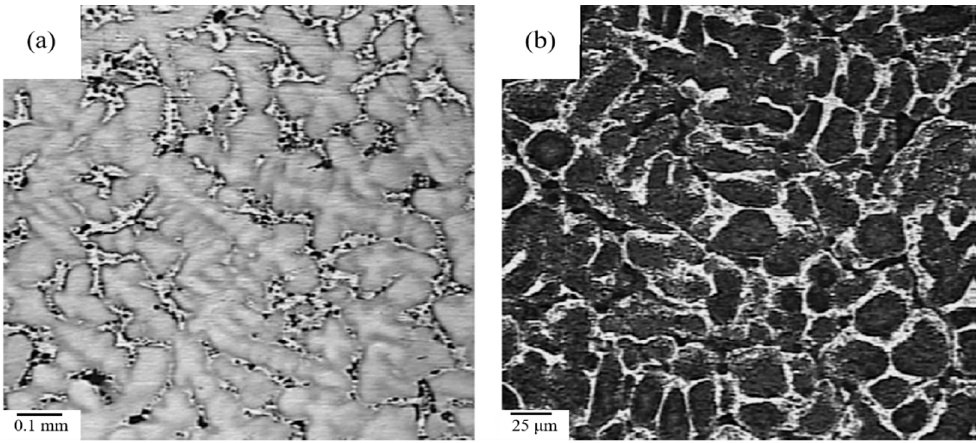
Figure 12. Microstructure of primary austenite grains of AHS steel: ( a ) steel A and ( b ) steel B [67].